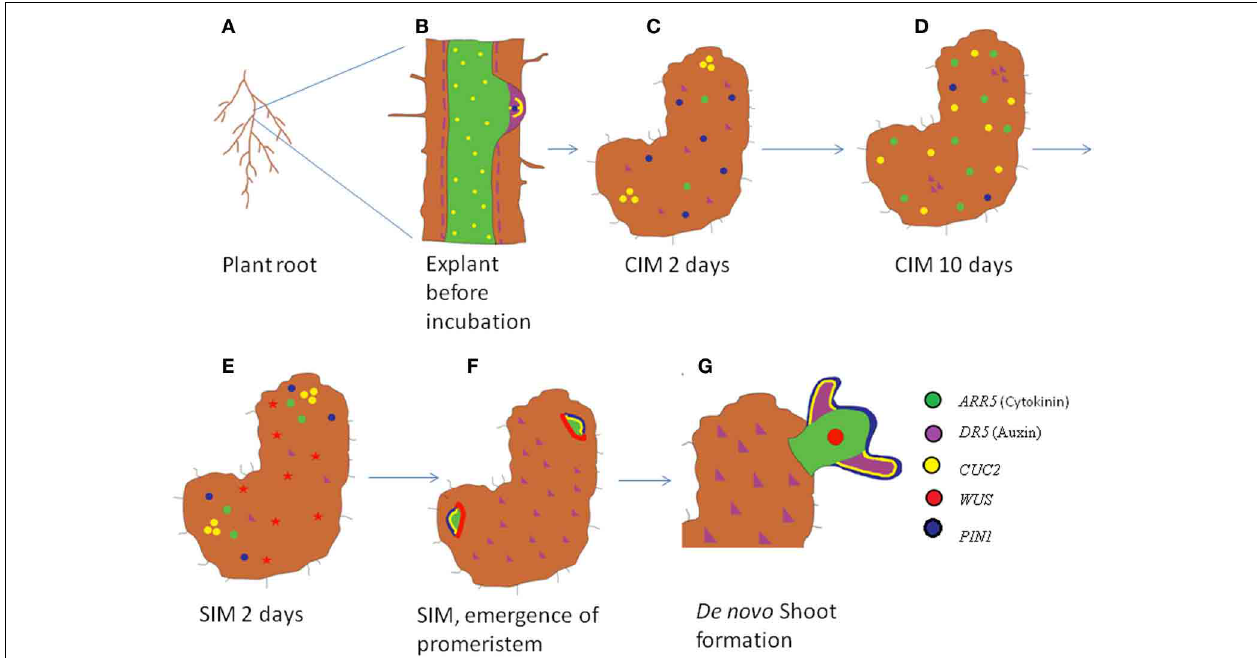
FIGURE 4 | Schematic of expression dynamics of regulatory genes during de novo shoot organogenesis. The root explant of Arabidopsis (A,B) with an emerging lateral root expresses auxin responsive DR5 at the tip of the LRP (purple) coinciding with the expression domain of PIN1 (magenta), cytokinin responsive ARR5 (green) in LRP and root stele and CUC2 (yellow) in a subset of cells in lateral root meristem and root stele (B) . The expression domain of auxin and PIN1 expands in the proliferating callus 2 days after CIM treatment, while CUC2 gets accumulated in patches and cytokinin level start rising (C) . Ten days after CIM induction,